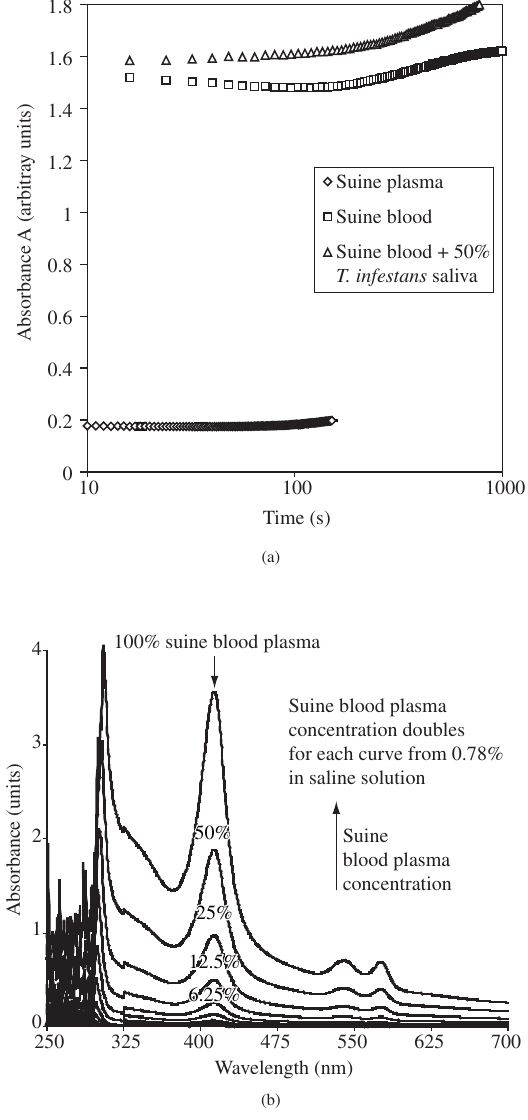
Figure 3. a) Microplate Reader absorption of pig blood, pig plasma and pig blood with 50% v/v of T. infestans saliva; and b) UV-Vis Spectrophotometer spectrum of pig plasma at different